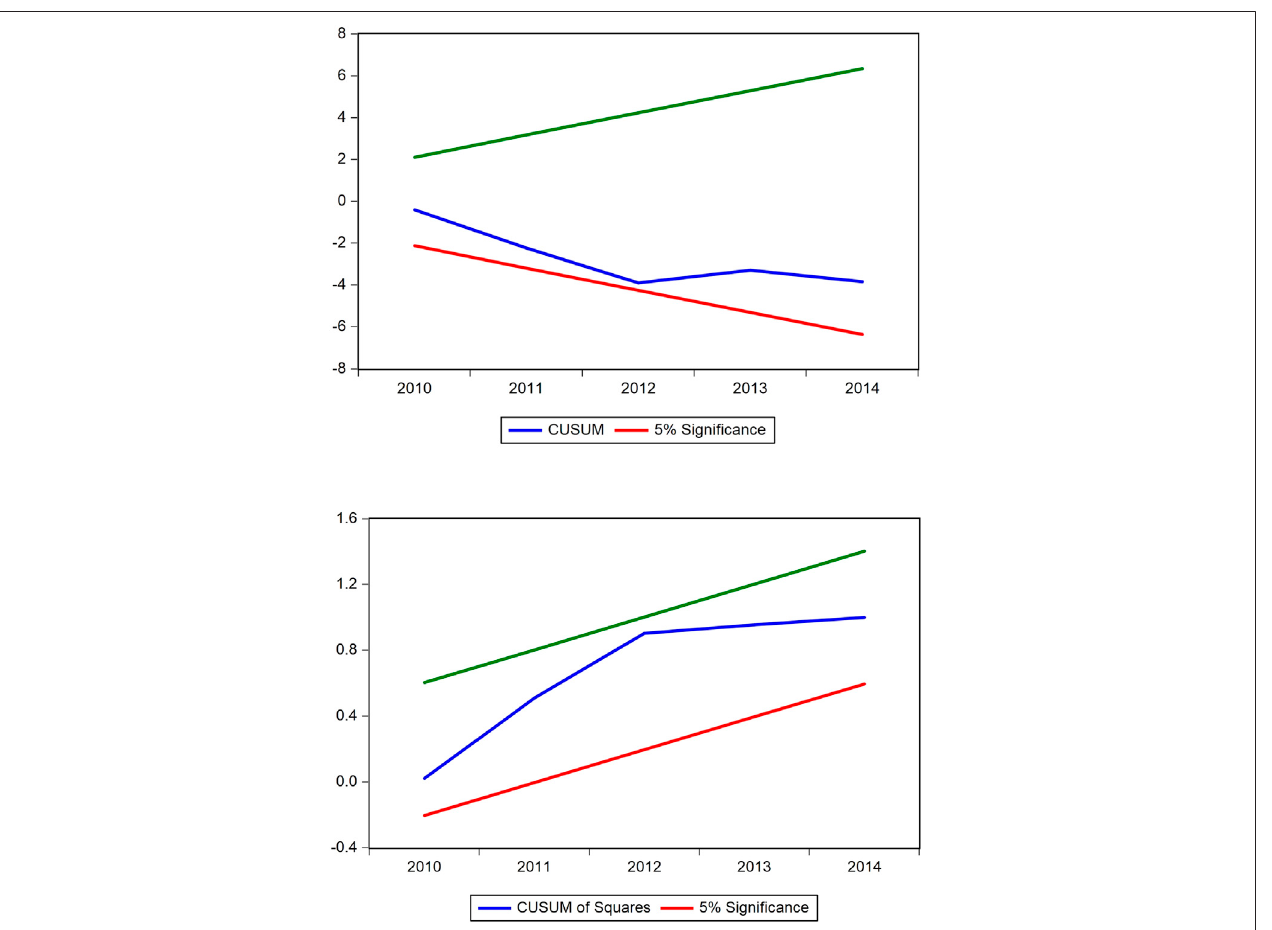
FIGURE 3 | Plot of cumulative sum (CUSUM) and cumulative sum of squares (CUSUM Sq.) at 5% signi fi cance.